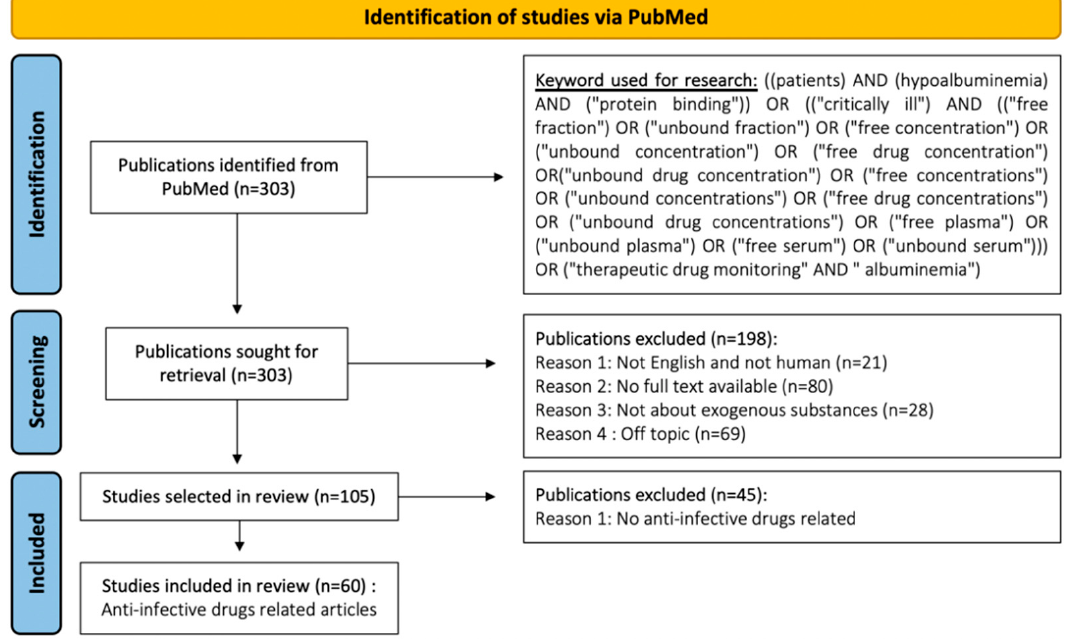
Figure 1. Flowchart describing PubMed review regarding unbound/free fractions/concentrations. This flowchart has been produced using the guidelines provided in [15].